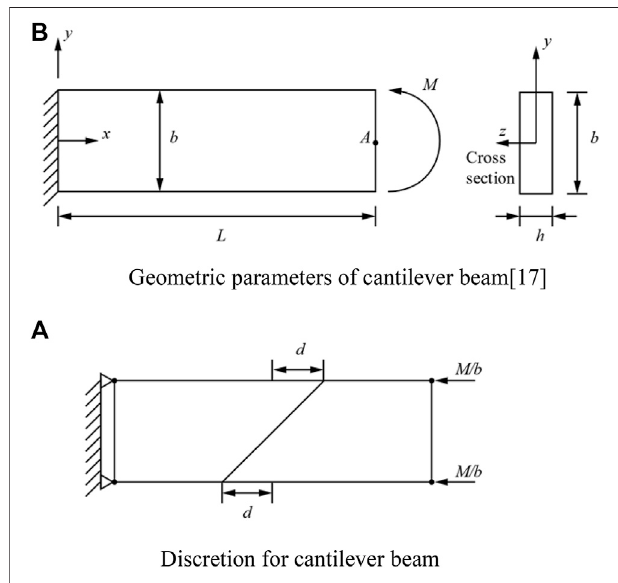
FIGURE 3 | The cantilever beam with imposed to bending moment. (A) Discretion for cantilever beam. (B) Geometric parameters of cantilever beam (Yang et al.,